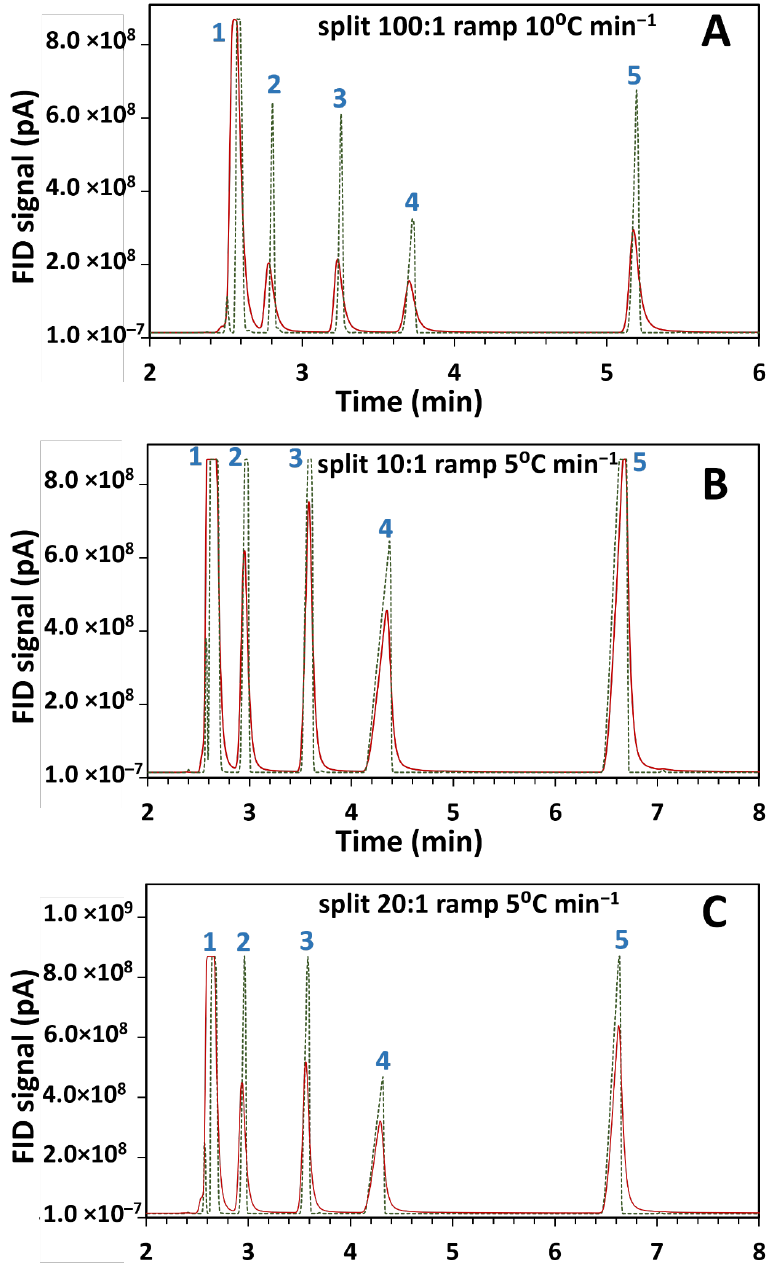
Figure 1. Comparison of flame ionisation detector (FID) results for overlaid chromatograms of gas chromatography-Fourier transform infrared-FID (GC–FTIR–FID) (continuous line) and GC–FID (dotted line) using a standard component mix injected at 50 ◦ C and analyzed with di ff erent split ratios and temperature ramps as ( A ) 100:1, 10 ◦ C min − 1 , ( B ) 10:1, 5 ◦ C min − 1 , and ( C ) 20:1, 5 ◦ C min − 1 . Components corresponding to the peaks are (1) dichloromethane (DCM) (solvent peak), (2) 2-butanol, (3) 2-pentanone, (4) 1-nitropropane and (5) m